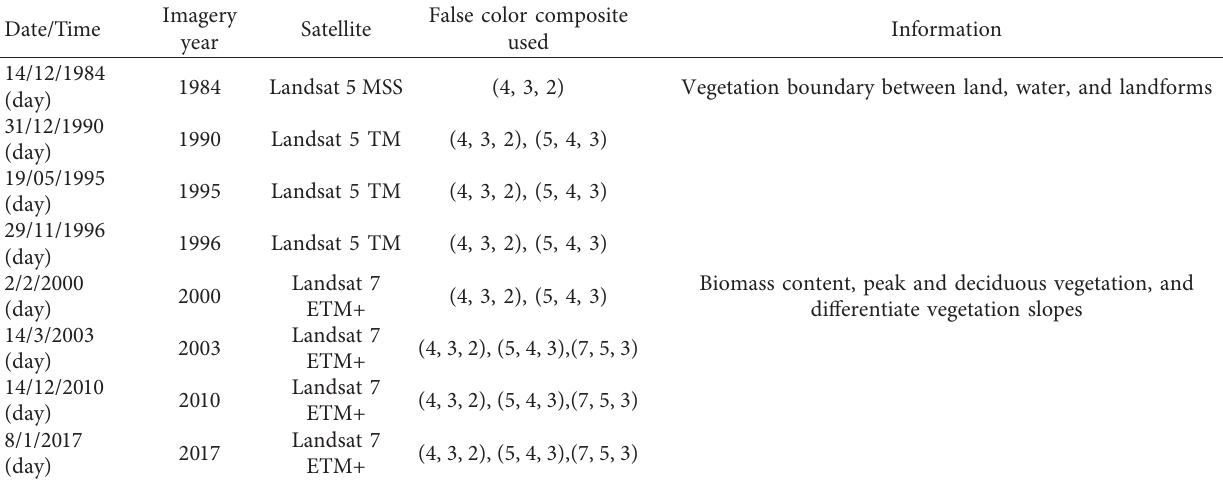
Table 3: Satellite imagery information with color composites used.